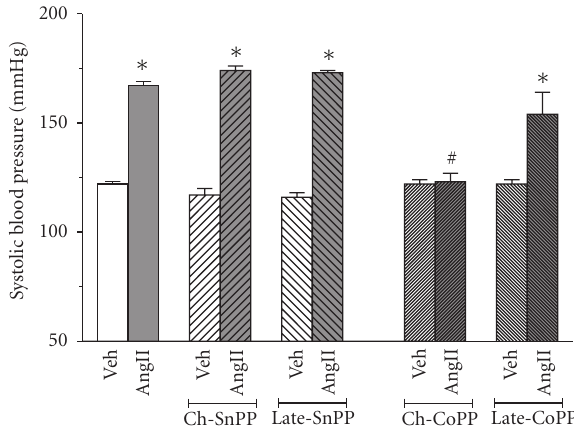
Figure 1: HO activity after chronic and late HO modulation. HO activity is determined by measuring the bilirubin formation in the following groups. Vehicle- (Veh-) treated ( n = 6), SP-AngII-treated ( n = 6), chronic-SnPP- (Ch-SnPP-) treated ( n = 6), SP-AngII/Ch- SnPP-treated ( n = 6), late-SnPP-treated ( n = 5), SP-AngII/late- SnPP-treated ( n = 5), chronic-CoPP- (Ch-CoPP-) treated ( n = 6), SP-AngII/Ch-CoPP-treated ( n = 6), late-CoPP-treated ( n = 5), SP- AngII/late-CoPP-treated ( n = 6) rats. ∗ P < 0 . 05 versus. control, # P < 0 . 05 versus. SP-AngII.